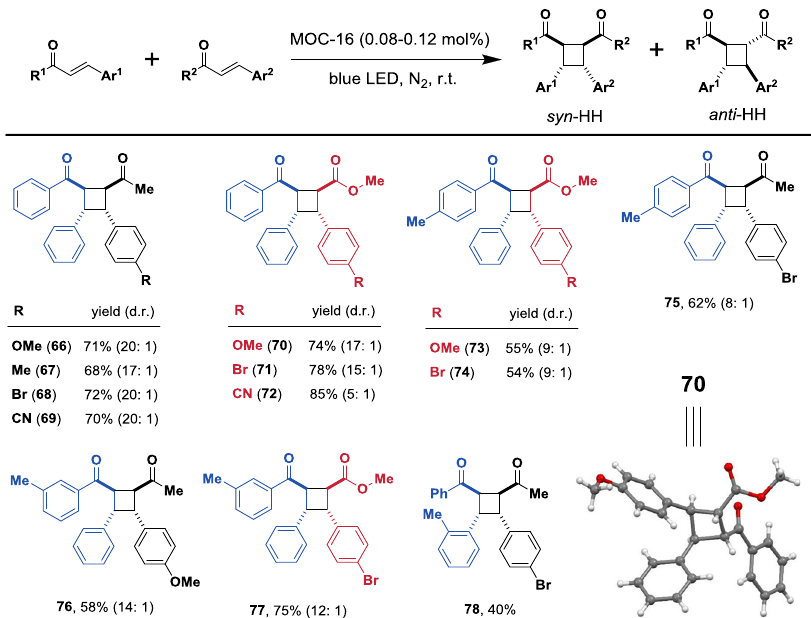
Fig. 3 Substrates scope of cross [2 + 2] cycloadditions. Isolated yields are shown with d.r. values in parentheses determined by 1 H NMR analyses. The data are based on average of two runs. The single-crystal structure of product 70 is